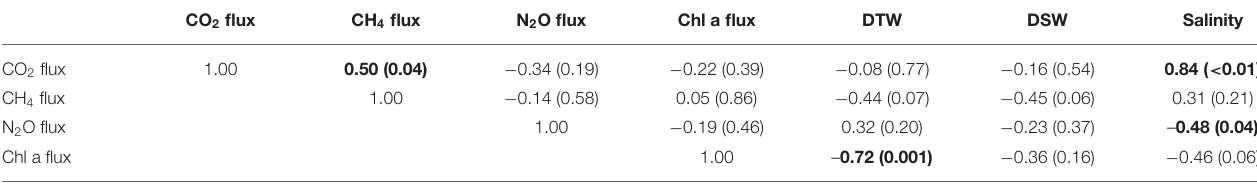
TABLE 1 | Pearson correlations between greenhouse gas fluxes, g dry oyster tissue (DTW) and g dry oyster shell (DSW), and salinity for C. virginica .